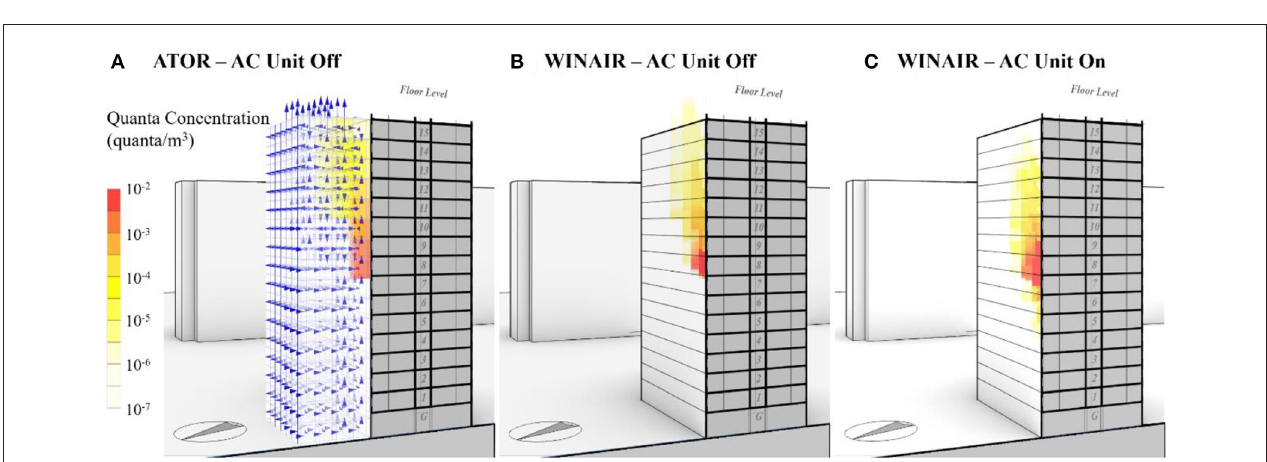
FIGURE 9 | (A) Simulated viral quanta concentration using ATOR without air conditioning (AC) usage; (B) simulated air pollutant plume using WINAIR without AC usage; and (C) simulated air pollutant plume using WINAIR with the AC unit in use in the primary patient’s apartment.